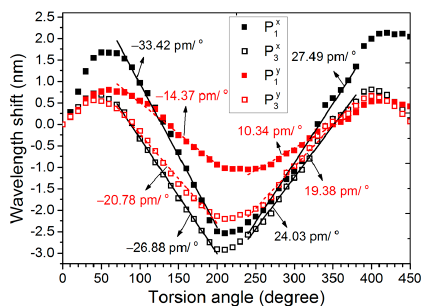
Figure 5. Torsion response of the fiber m-MZI using highly birefringent ATC-PCF ( L ~ 5.1 cm).